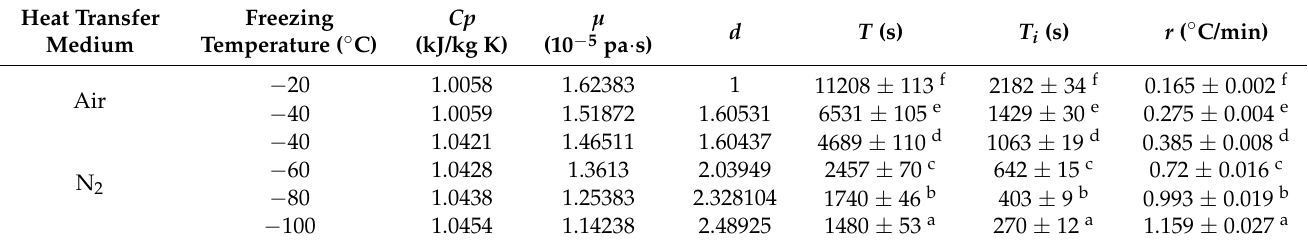
Table 1. Technical index relating to heat transfer and freezing efficiency of chestnut kernels